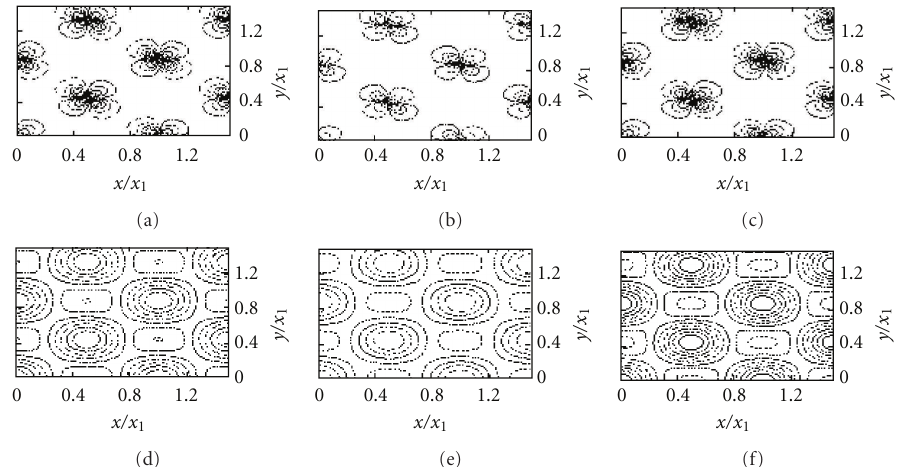
Figure 2: Variation of vortex lattice structure corresponding to the s - and d -wave order parameter components ω s ( x , y ) ((a)–(c)) and ω d ( x , y ) ((d)–(f)) for di ff erent temperatures ( t = 0 . 9,0 . 7,0 . 5), respectively, calculated by the extended two-order parameter GL theory. Other parameters used for the calculation are GL parameter κ = 72, magnetic field induction b = 0 . 8, and mixed gradient coupling parameter (cid:2) v = 0 . 1, β sd = 0.